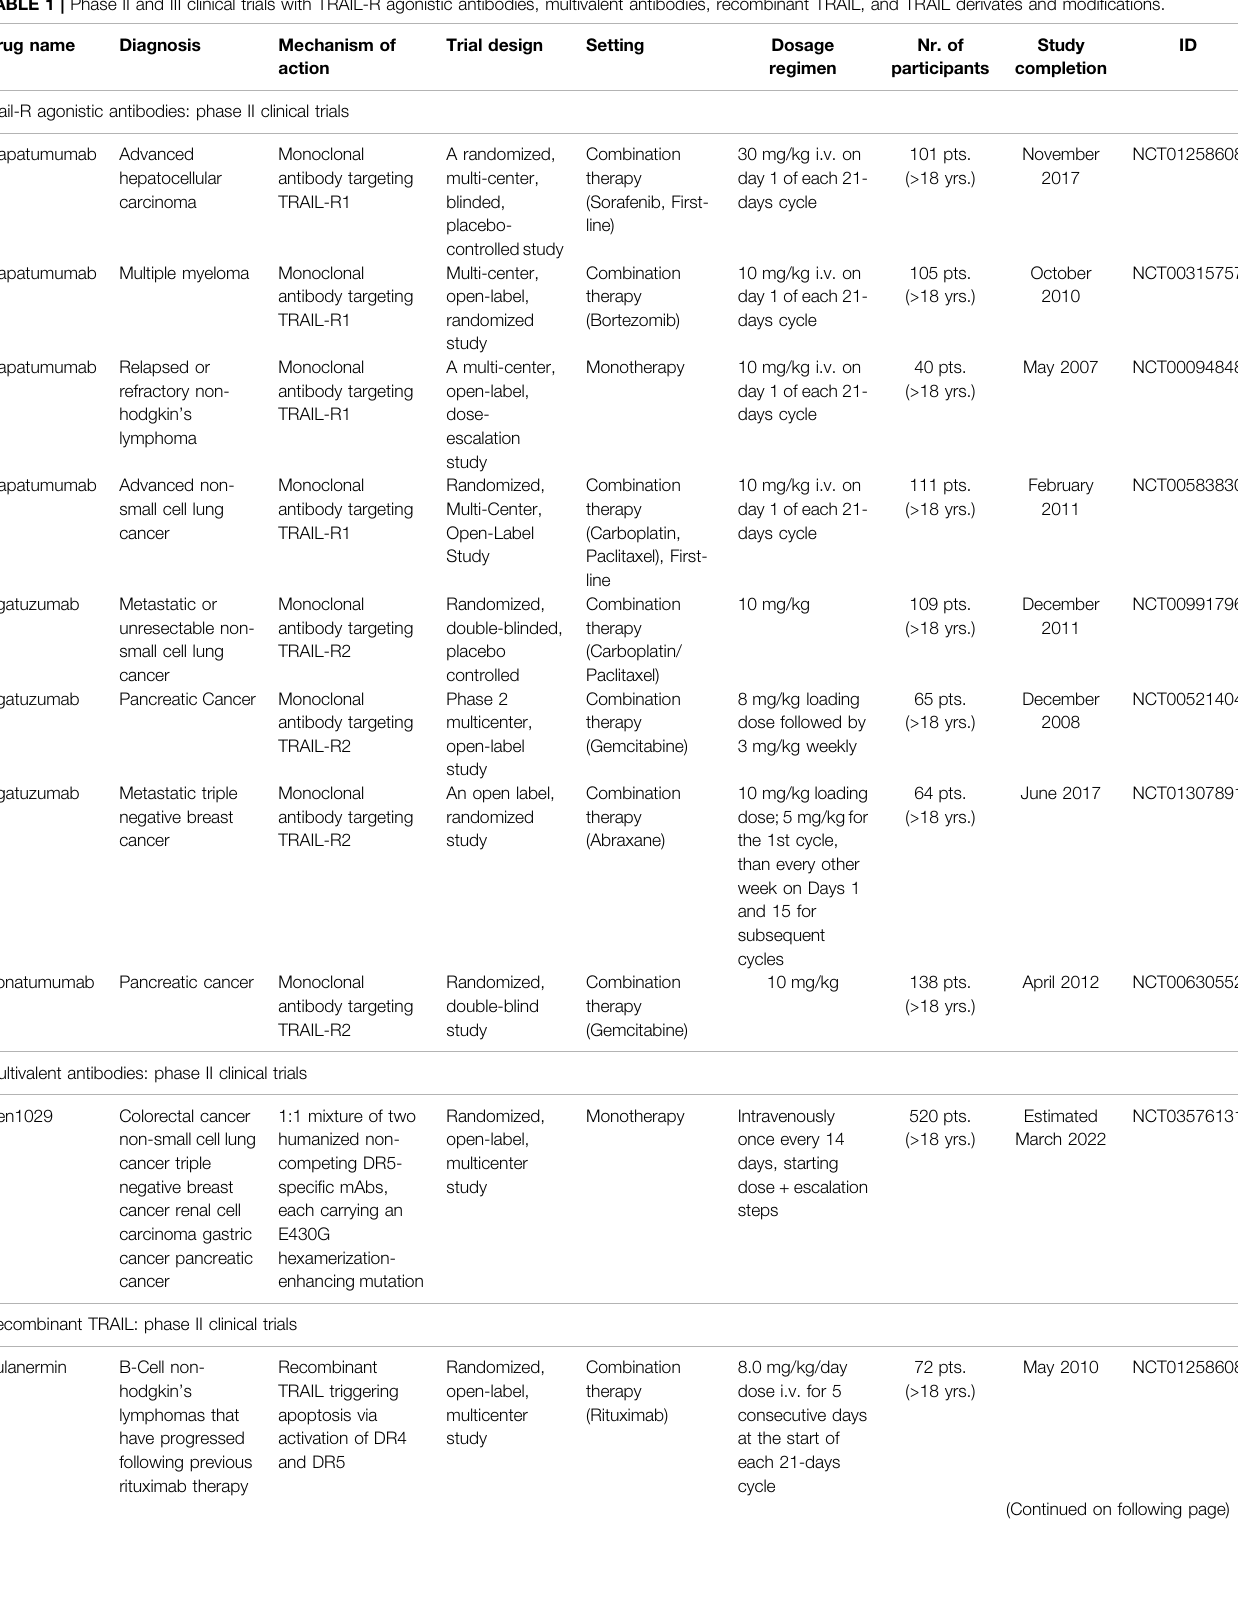
TABLE 1 | Phase II and III clinical trials with TRAIL-R agonistic antibodies, multivalent antibodies, recombinant TRAIL, and TRAIL derivates and modi fi